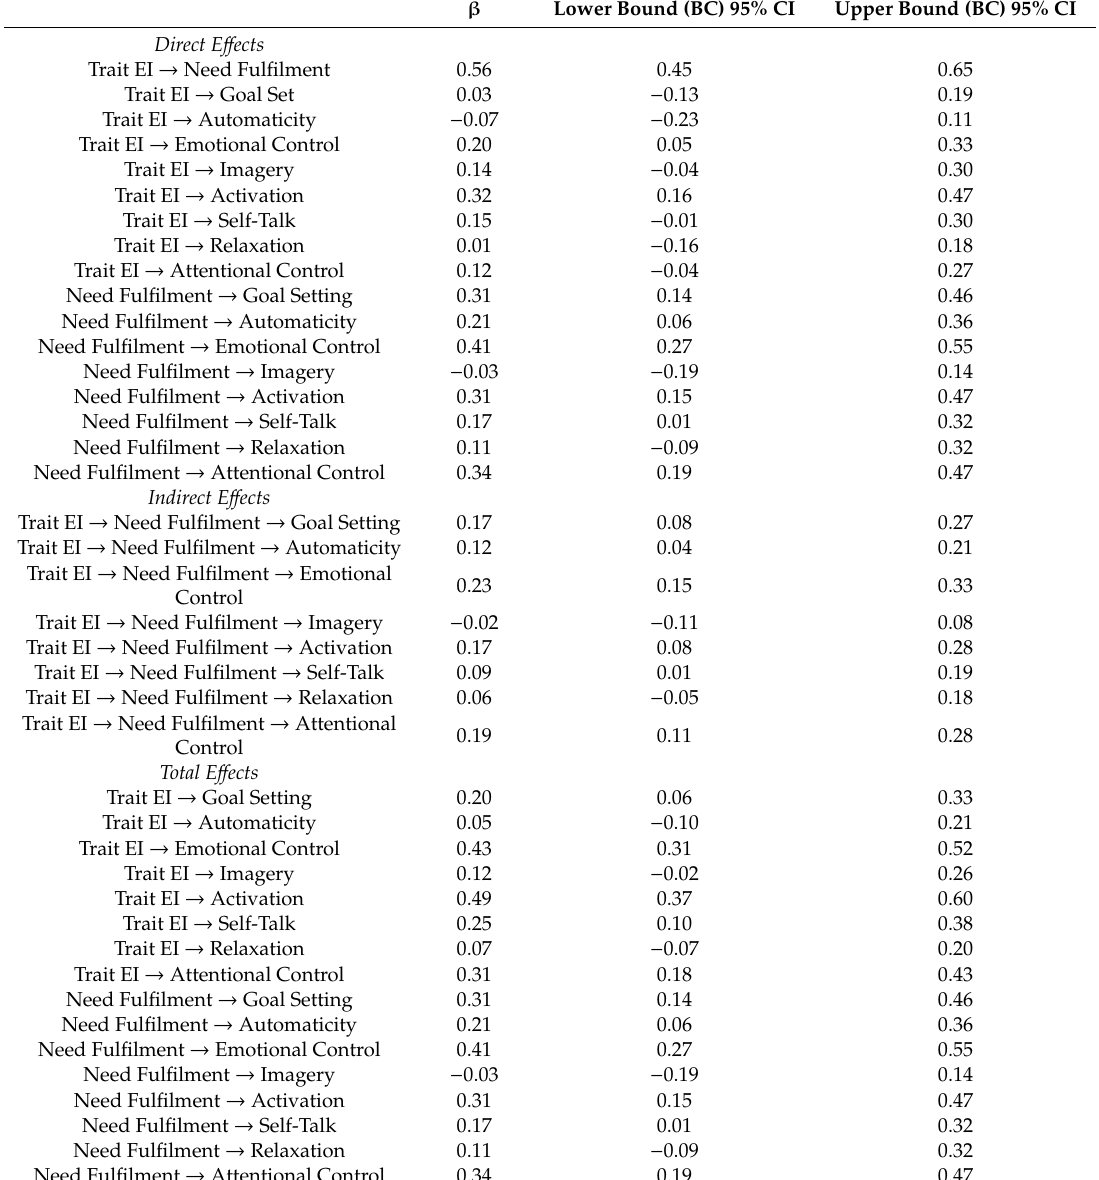
Table 3. Direct E ff ects, Indirect E ff ects, and Total E ff ects in training contexts.